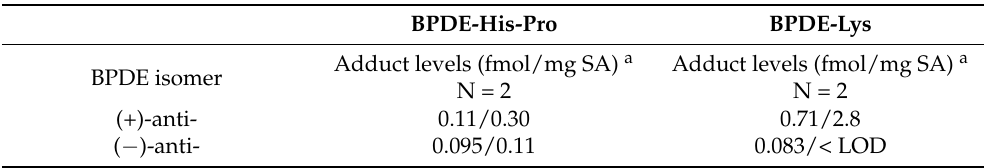
Table 3. Levels of adducts from (+)-anti- and ( − )-anti-BPDE in mice euthanized 3 days after treatment with benzo[ a ]pyrene (100 mg/kg of body weight). (Two individual mice were